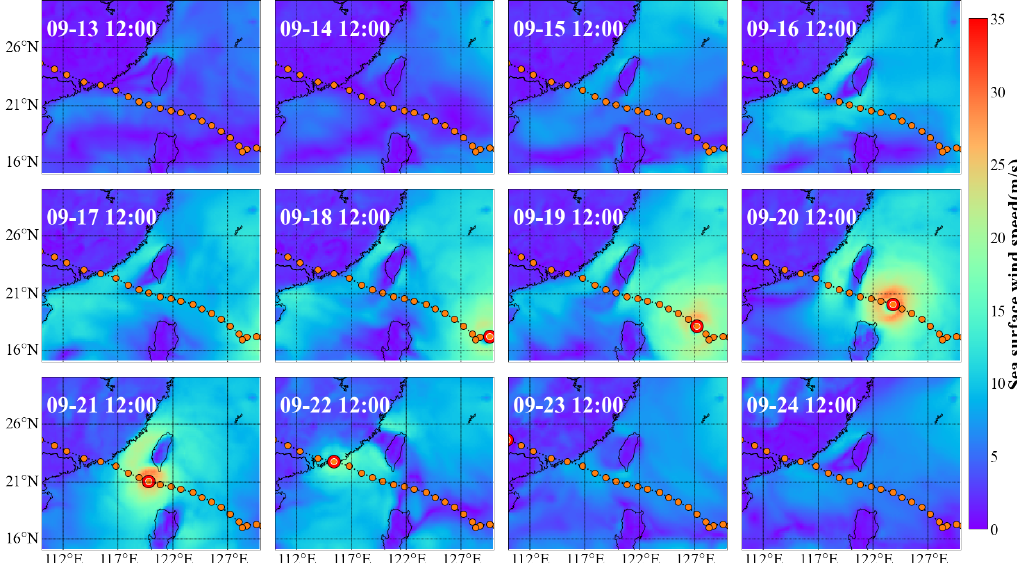
Figure 9. Time evolution of the daily sea surface wind speed from 13 September to 24 September. The big circle in red is the location of the typhoon at 12:00 that day. The SSTAs were calculated from 19 September to 24 September compared to the average SSTA from September 9 to 15. The cooling shown in Figure 10 may not always align closely with the typhoon trajectory due to the potential influence of various factors, including ocean currents and atmospheric conditions. For instance, the observed cooling on September 20 could have been impacted by local oceanic and atmospheric conditions, such as changes in the intensity of the typhoon in each quadrant or wind direction. On 21 September, the SST decreased by 4.5 °C compared to the mean SSTA from September 9 to 15. This decrease was more pronounced on the right side of the typhoon track (blue color), which aligns with previous research findings [2,30,34,48].